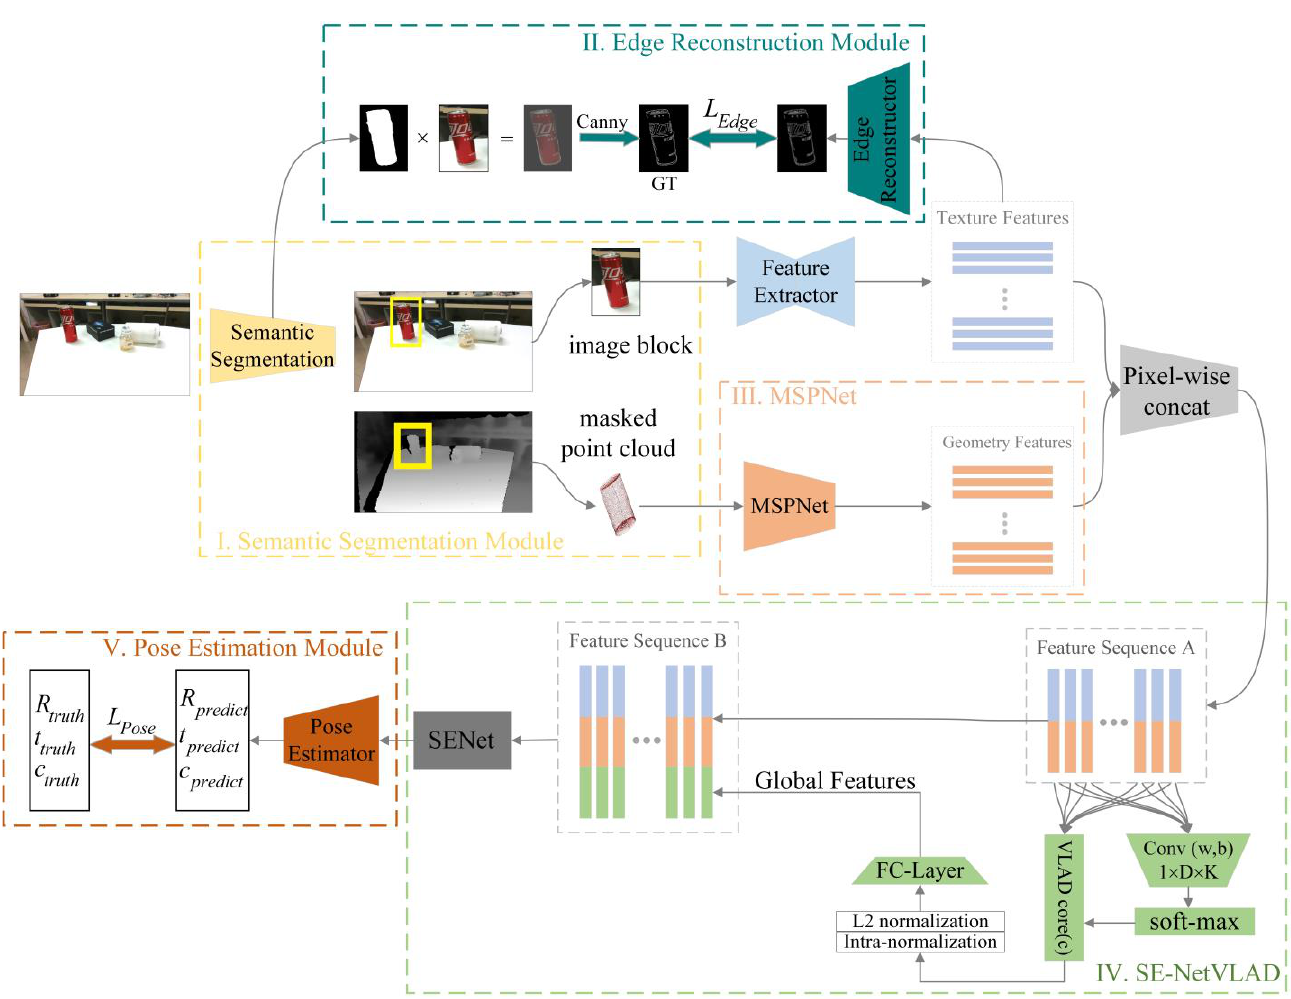
Figure 1. The overall architecture of SaMfENet. SaMfENet can be divided into five parts. First, the input image is semantically segmented to obtain image blocks containing the object and the object point cloud reconstructed from the depth images. The image block is fed into the image feature extraction module to extract features afterward. We add edge feature constraints to improve the attention of the image feature extraction module to edge features. At the same time, the object point cloud is fed into MSPNet to extract the multi-scale geometric features of the point cloud. In addition, the two features emerged at the pixel level to obtain a multi-modal dense feature sequence, which is fed into SE-NetVLAD to extract the global features. Finally, the dense feature sequence is fed into the pose estimator to predict the rotation and translation.